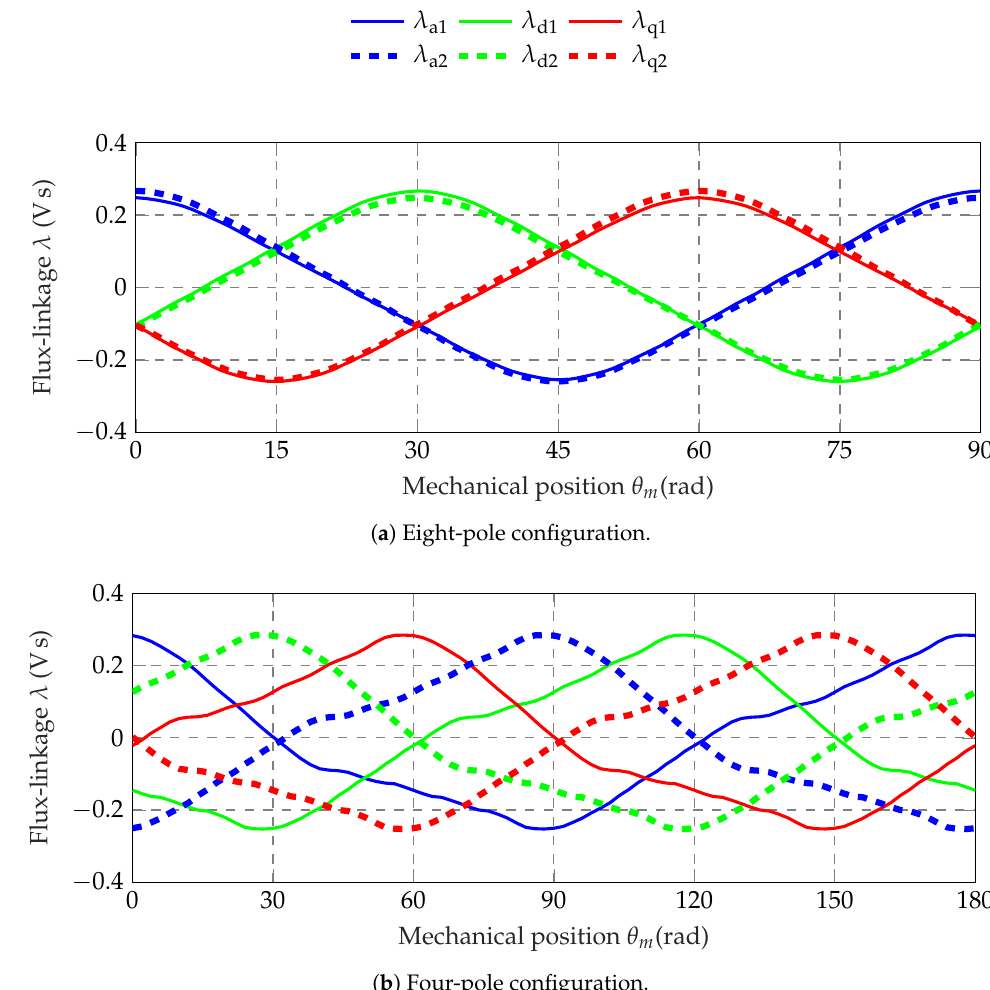
Figure 13. No-load flux density waveform along the air gap.